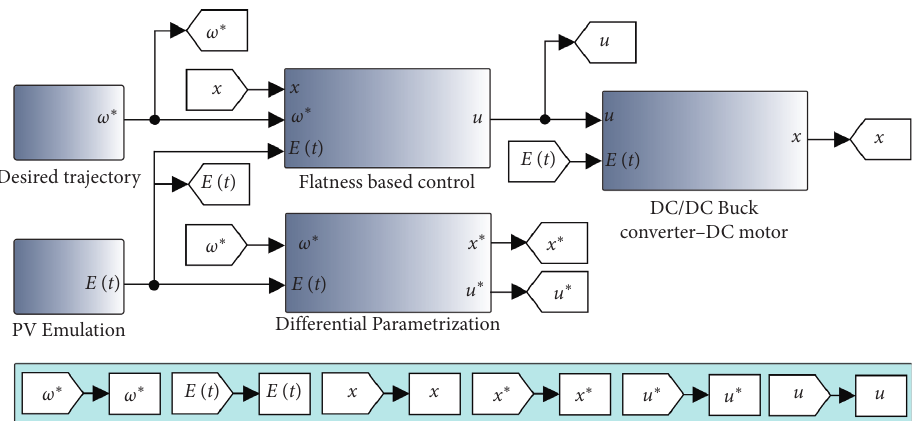
Figure 2: Block diagram associated with the implementation, in MATLAB-Simulink, of the flatness-based control in the DC/DC Buck converter-DC motor